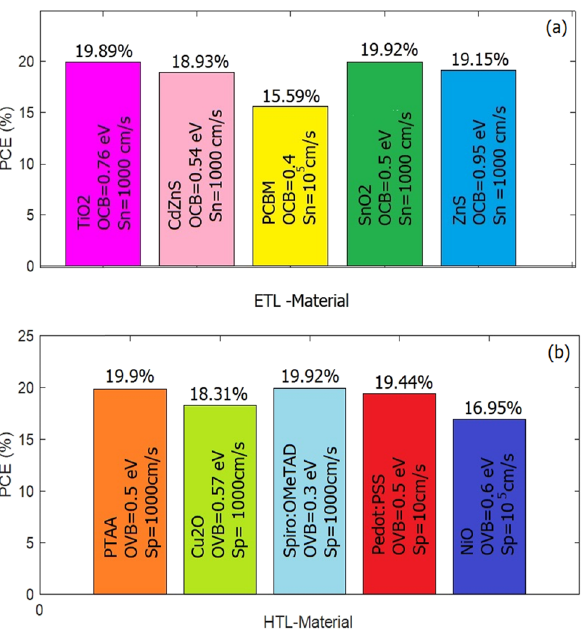
Figure 3: Power conversion e ffi ciency: ( a ) for di ff erent ETL materials; ( b ) for di ff erent HTL materials.